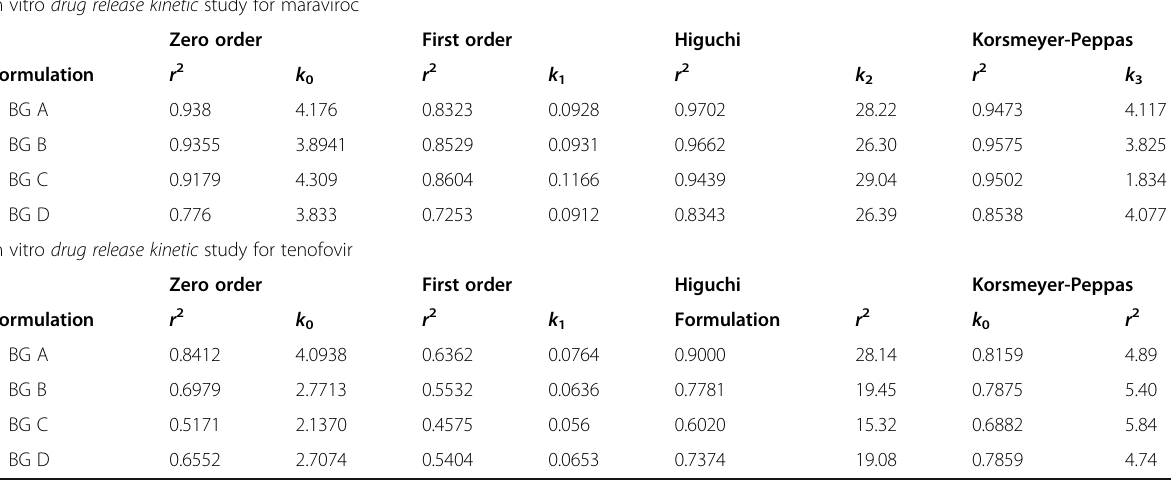
Table 3 In vitro drug release kinetic study of the API from the various tenofovir and maraviroc bigel formulations In vitro drug release kinetic study for maraviroc Zero